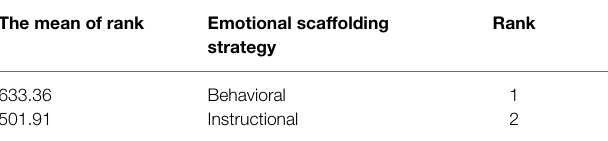
TABLE 9 | The ranks of behavior and pedagogy-related emotional scaffolding strategies in the teachers’ views. The mean of rank Emotional scaffolding strategy